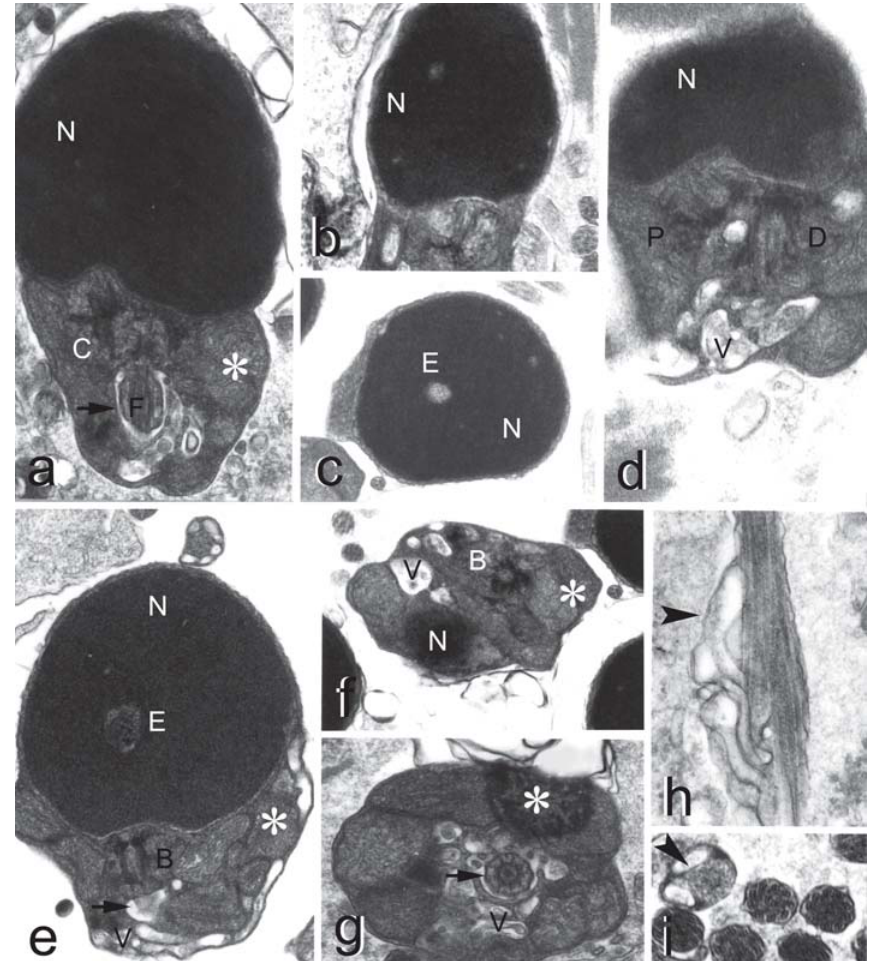
Fig. 10. Spermatozoa of Callichthys callichthys . a ) Spermatozoon in longitudinal section. b and c ) Nucleus in longitudinal and cross sections. d ) Centriolar arrangement. e to g ) Midpiece in longitudinal and transverse sections showing mitochondria, vesicles, and cytoplasmic channel. h and i ) Flagellum in longitudinal and cross sections. ( a, g, h ) X 31500; ( b, e ) X 23000; ( c, f ) X 17000; ( d, i ) X 42000. D: distal centriole; E: electron-dense structure; F: flagellum; N: nucleus; P: proximal centriole; V: vesicles; Asterisk: mitochondria, Arrow: cytoplasmic channel; Arrowhead: lateral membranous